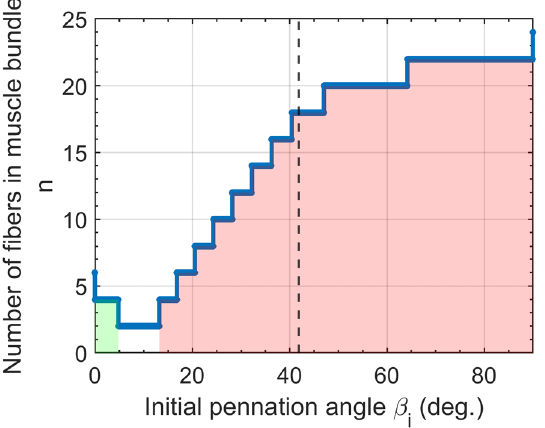
Figure 13. Variation in the number of fibers in muscle bundle with initial pennation angle with the pinned boundary condition. The green shaded region is associated with laterally arranged fibers and the pink shaded region indicates centrally arranged fibers. The white region indicates where only one pair of fibers can fit in the prescribed bounding